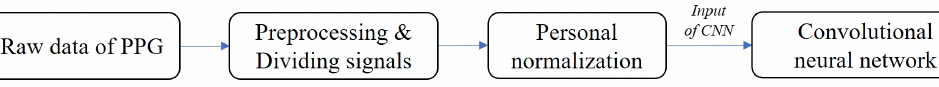
Figure 2. Emotion recognition procedure.